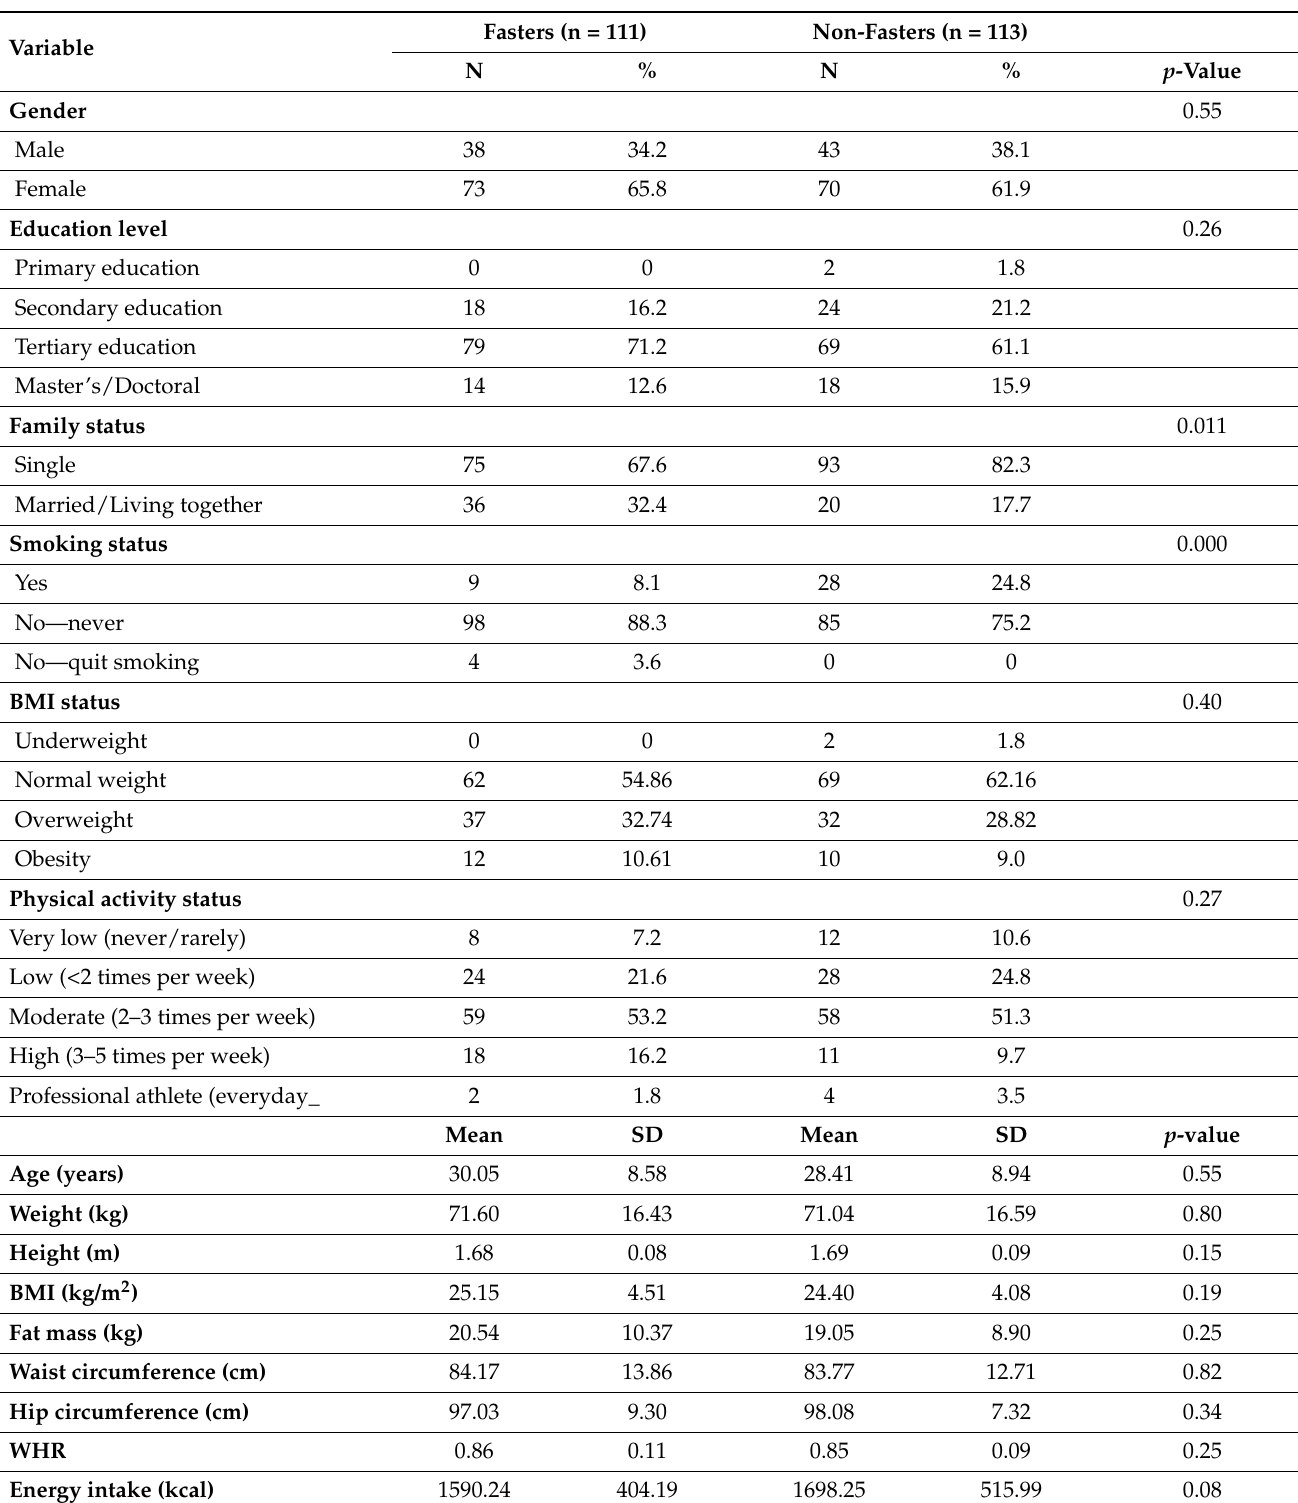
Table 1. Comparative analysis by